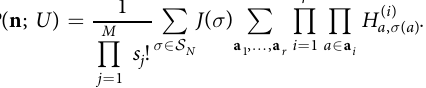
In the quantum case, the fact that it is impossible to trace the individual paths of indistinguishable particles through a network results in the cross-particle interference terms, weighted by a function J ( σ ) acting on the group  of permutations σ of N objects 32, 34 (see Supplementary Information): J ( B ) ( σ ) = 1 for indistinguishable bosons N